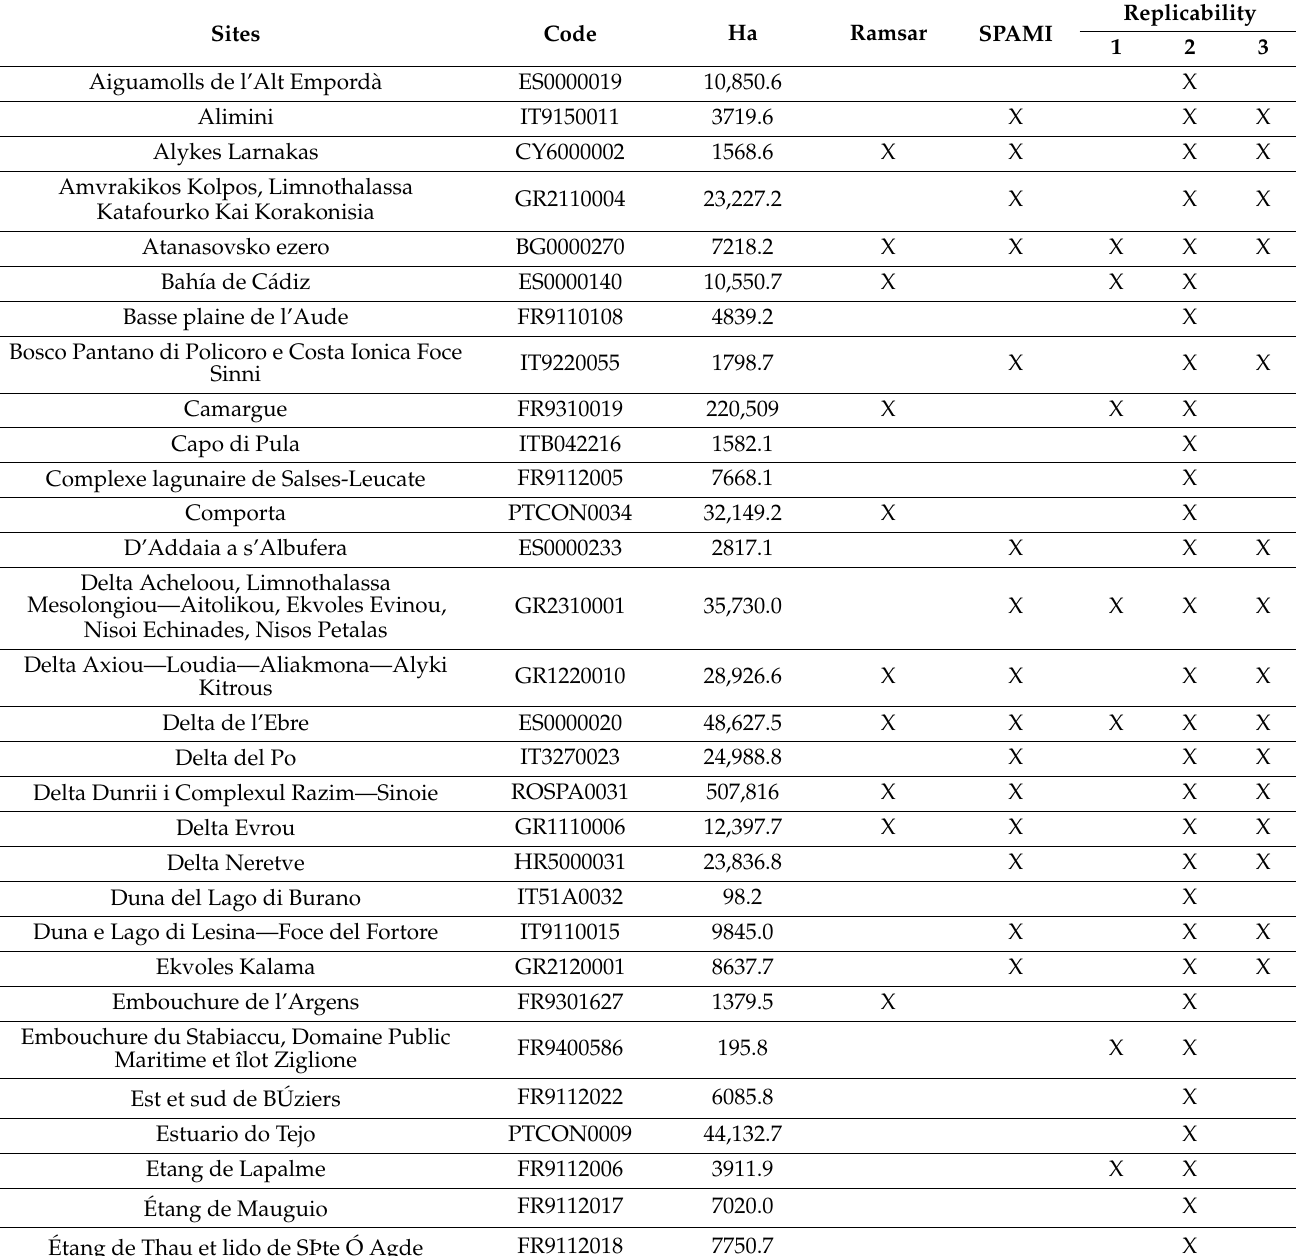
Table A1. Sites of the Natura 2000 network. Characteristics and